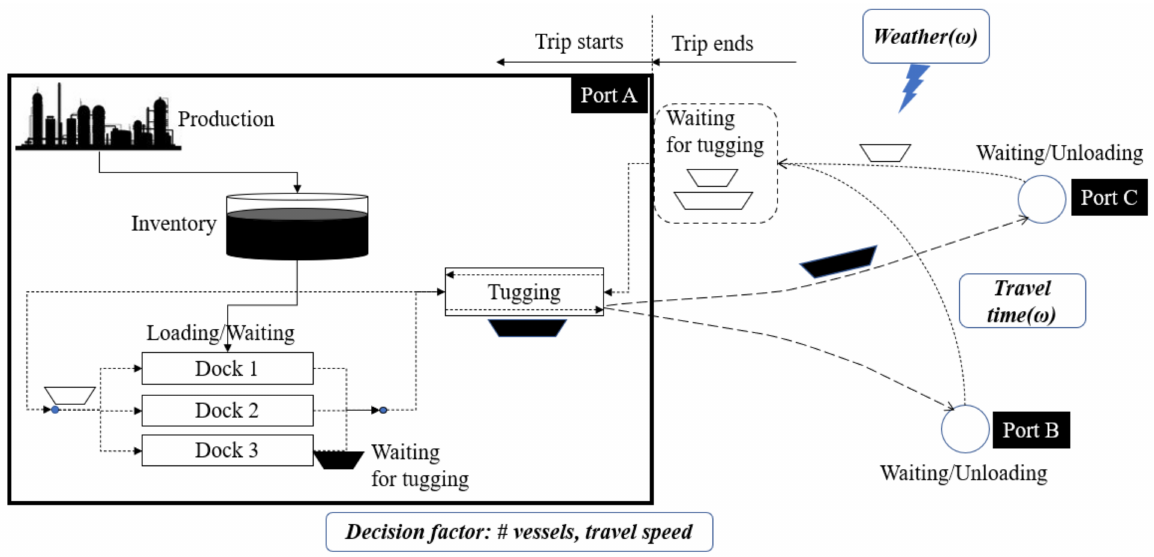
Figure 1. Schematic structure of the studied closed-loop vessel dispatching